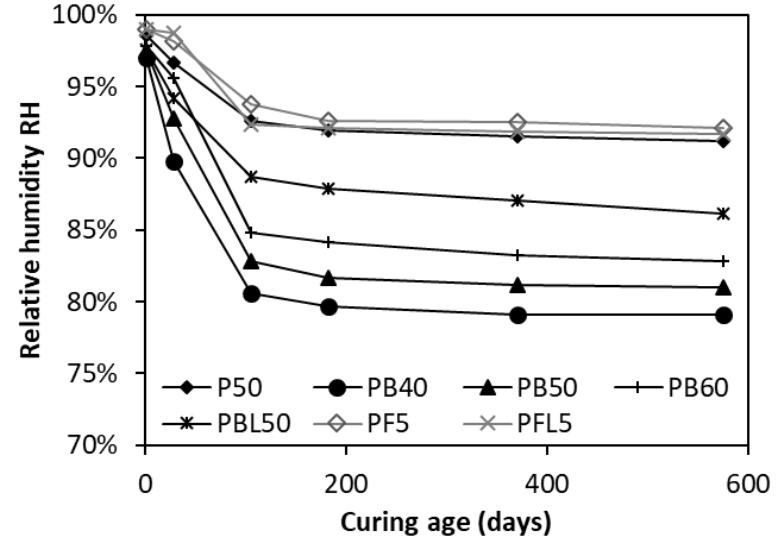
Figure 7. Effect of SCMs on relative humidity in blended pastes. Figure 7. E ff ect of SCMs on relative humidity in blended